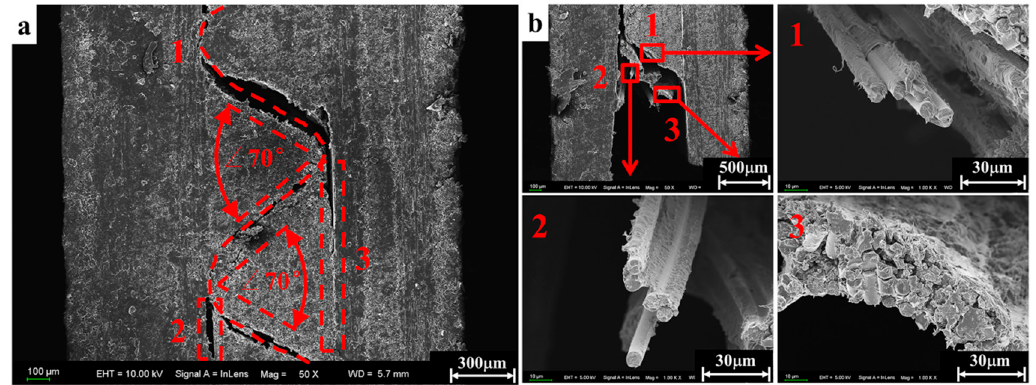
Figure 10. Delaminating and cracking damage occurred at a strain rate of 1832/s. ( a ) Macroscopic appearance of a crack. ( b ) Microscopic failure characteristics.